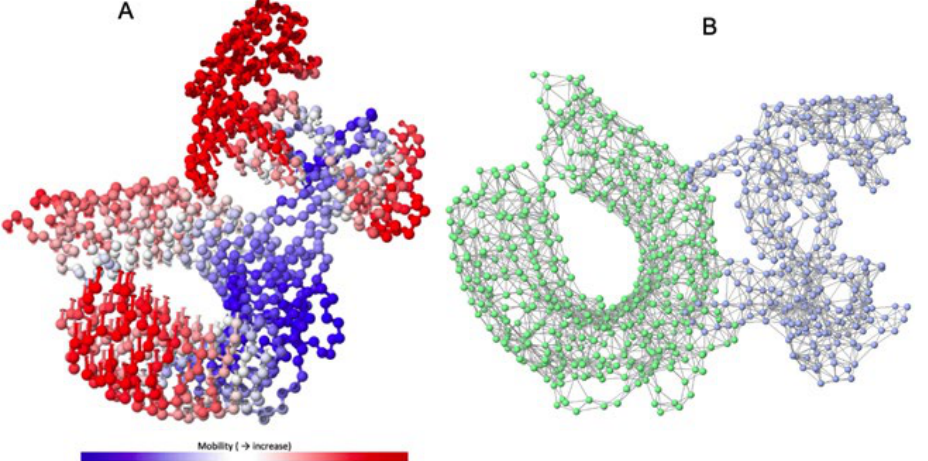
Fig. 8. (A) The mobility of Vaccine construct-TLR-4 complex (B) Elastic spring network across the atoms of vaccine- TLR-4